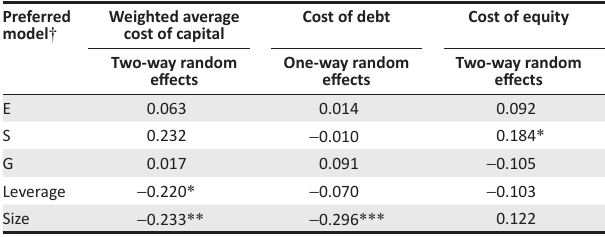
TABLE 7: Regression results for the individual environmental, social and corporate governance disclosure scores for industrials